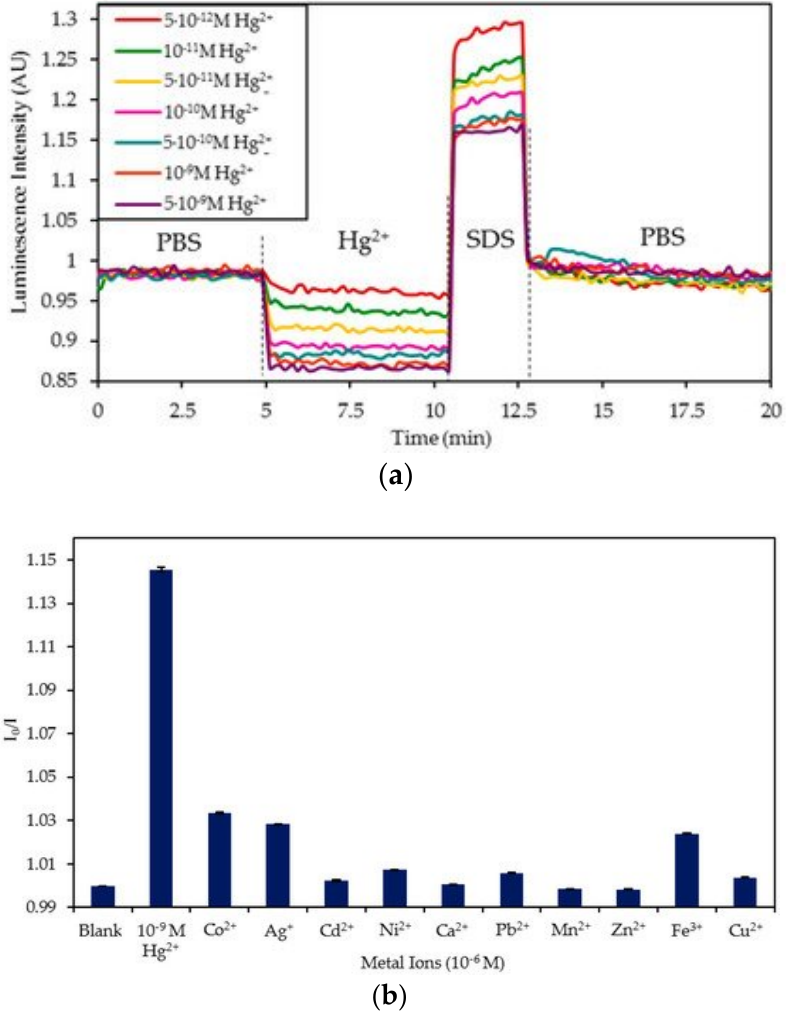
Figure 9. ( a ) Normalized luminescence variation for 5 × 10 − 12 M, 10 − 11 M, 5 × 10 − 11 M, 10 − 10 M, 5 × 10 − 10 M, 10 − 9 M and 5 × 10 − 9 M concentrations in 10 mM PBS (pH 7.4), and regeneration with 0.5% w / w SDS. ( b ) I 0 /I ratio of the sensor in the absence of metal ions (blank), in the presence of 10 − 9 M Hg 2+ and in the presence of 10 − 6 M of Co 2+ , Ag + , Cd 2+ , Ni 2+ , Ca 2+ , Pb 2+ , Mn 2+ , Zn 2+ , Fe 3+ , and Cu 2+ ions. Reprinted with permission from [51].